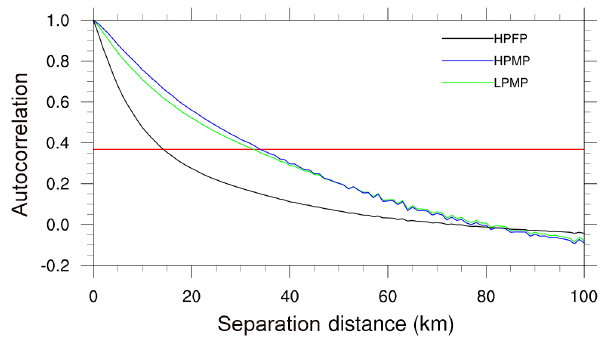
Figure 2. The averaged spatial autocorrelations of precipitation for each precipitation type. The red line indicates the e -folding